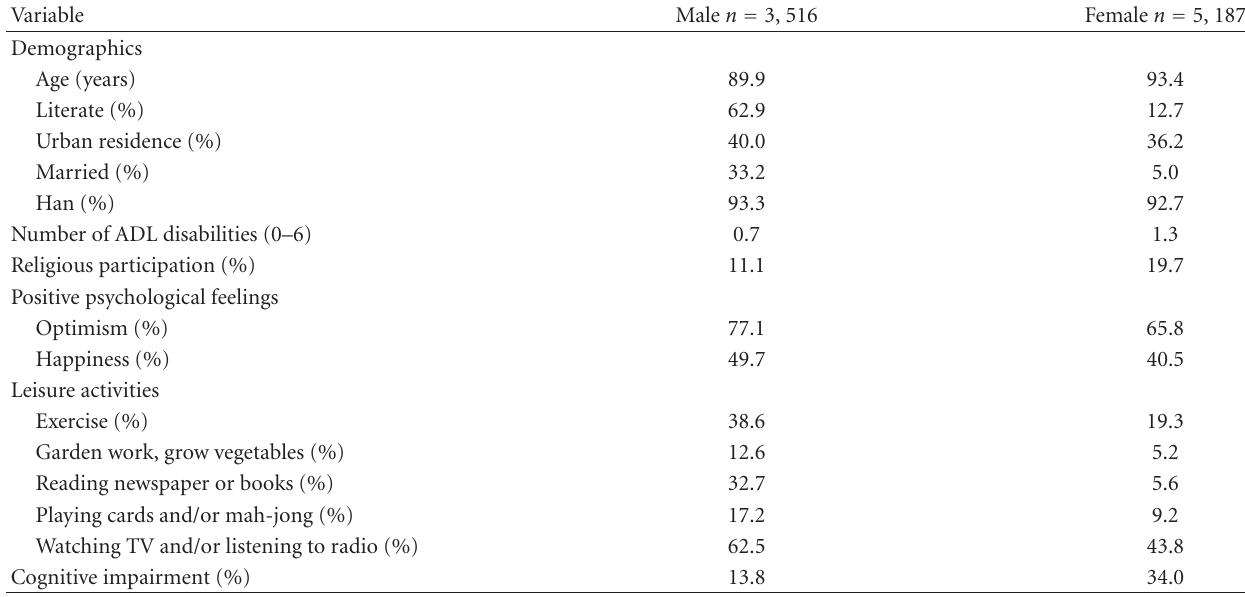
Table 1: Characteristics of the Oldest-Old in China, by Gender: